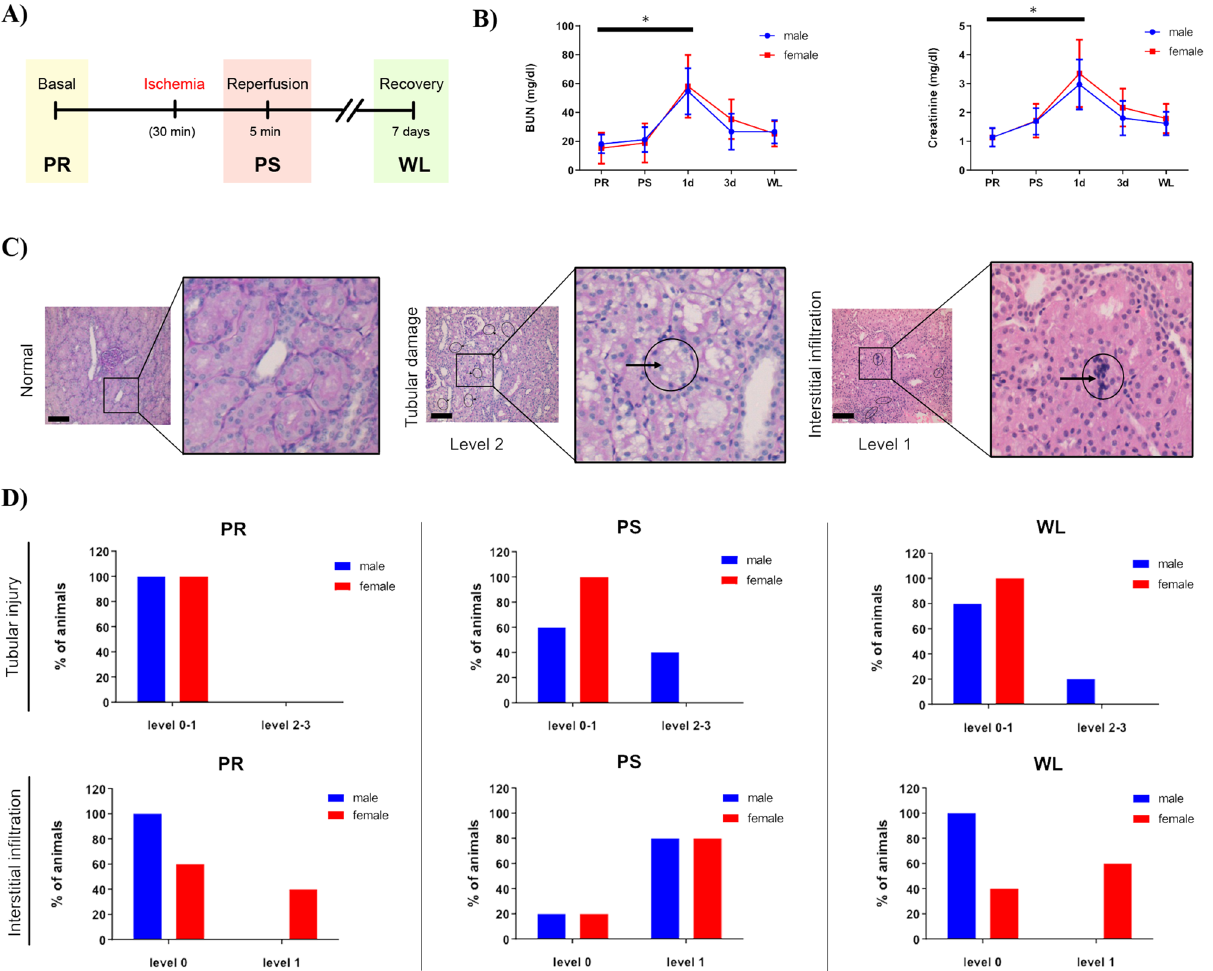
Figure 1. Assessment of biochemical parameters and histological examination following porcine renal ischemia/reperfusion injury. ( A ) Experimental design of renal unilateral IRI following contralateral nephrectomy. Ischemia was induced for 30 min. Data were collected before injury, 5 min and 7 days following renal clamping. ( B ) Measurement of blood urea nitrogen (BUN) and serum creatinine (SCr) levels in males (blue) and females (red). The “y” axis represents blood urea nitrogen and serum creatinine concentration, respectively, and the “x” axis represents the time points. Average values ± SEM are plotted in the graph (N = 5). ( C ) Representative images of different levels of tubular injury and interstitial infiltration in pig kidney. Arrows indicate specifically damaged cells. Magnification = 20X, scale bar = 100 µm. ( D ) Quantification of tubular injury (upper panel) and interstitial infiltration (lower panel) scored by an expert pathologist was classified by group and sex (males in blue, females in red). The y-axis represents the % of animals showing each level of injury or infiltration, respectively. BUN blood urea nitrogen, PR pre-ischemia, PS post-ischemia, WL one week later. * p <